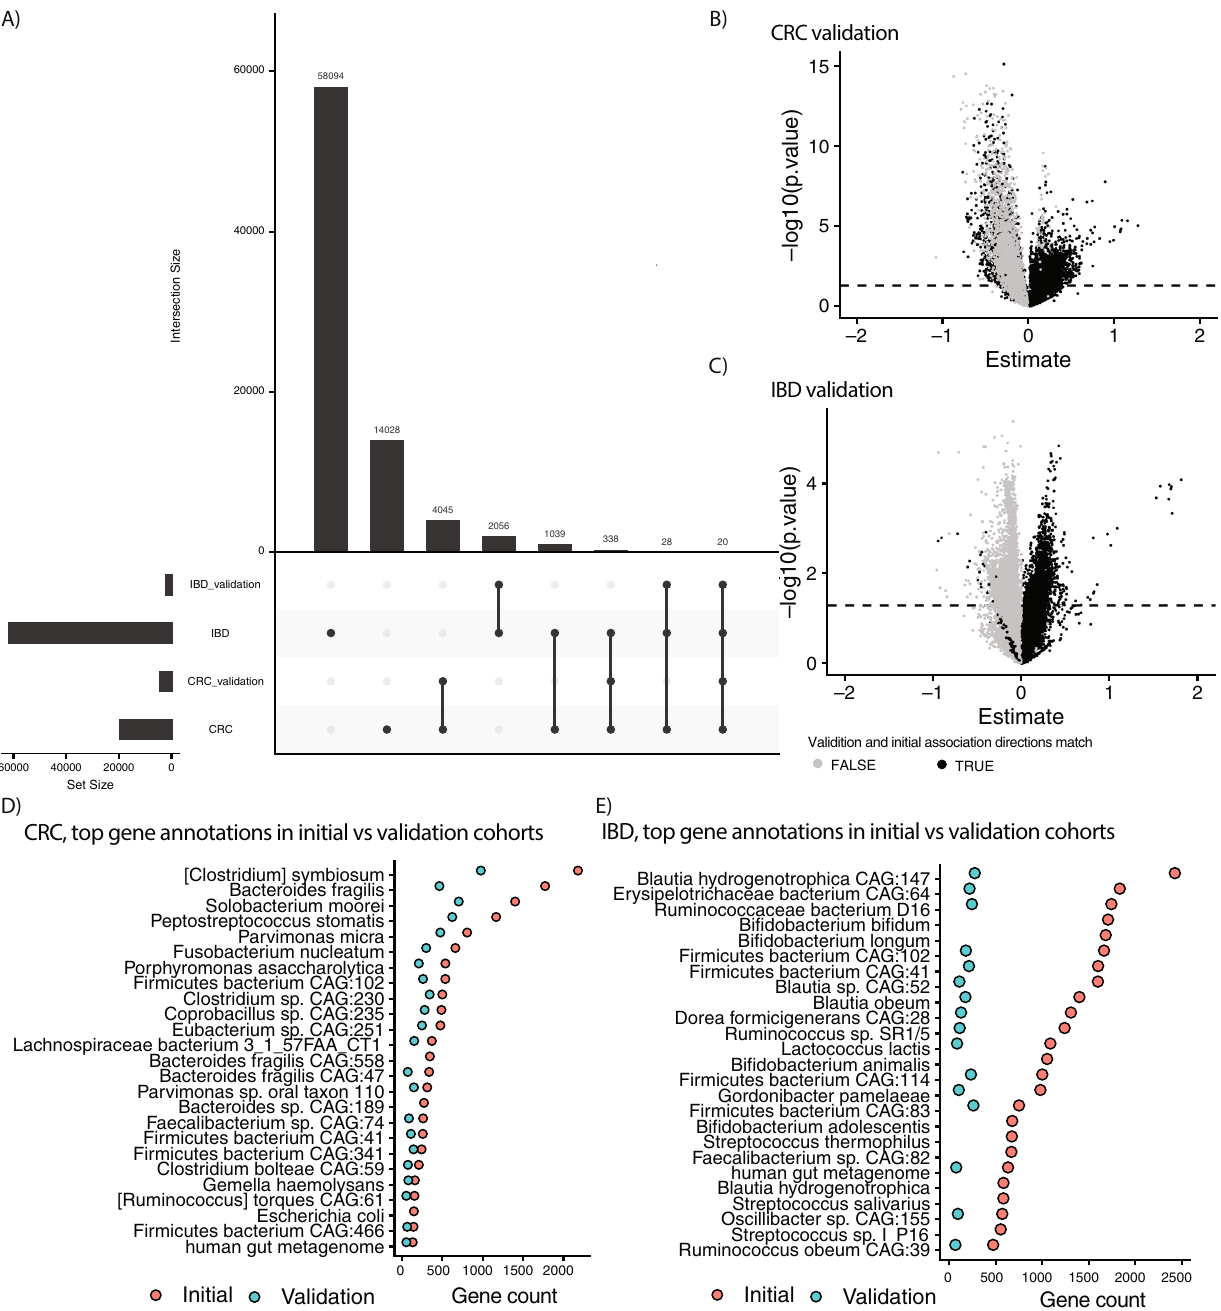
Fig. 7 Validation of gene-level architectures for CRC and IBD. We used unadjusted, univariate linear models to test the association between gene abundance and disease state for the genes associated with IBD and CRC in two cohorts not analyzed in our initial study. A Overlaps between the initial and validation cohorts in terms of signi fi cant genes. B , C Volcano plots of CRC and IBD estimate sizes and nominal log 10 P values for validation cohorts. Each point represents a different gene family. Dotted line is nominal ( P value < 0.05) signi fi cance. Exact P values < 0.05 are shown above the line. Y axes are nominal log 10 P values. X axes are the beta-coef fi cient on the binary, independent disease variable of interest. Black dots indicate the association direction (e.g., positive vs. negative) matched in the initial cohort(s), gray indicates initial, and validation associations did not have the same direction. D , E The top 25 taxonomic annotations (by frequency) of genes associated with CRC and IBD in the initial cohorts and how many of these are also found in the top 25 annotations of genes in the validation